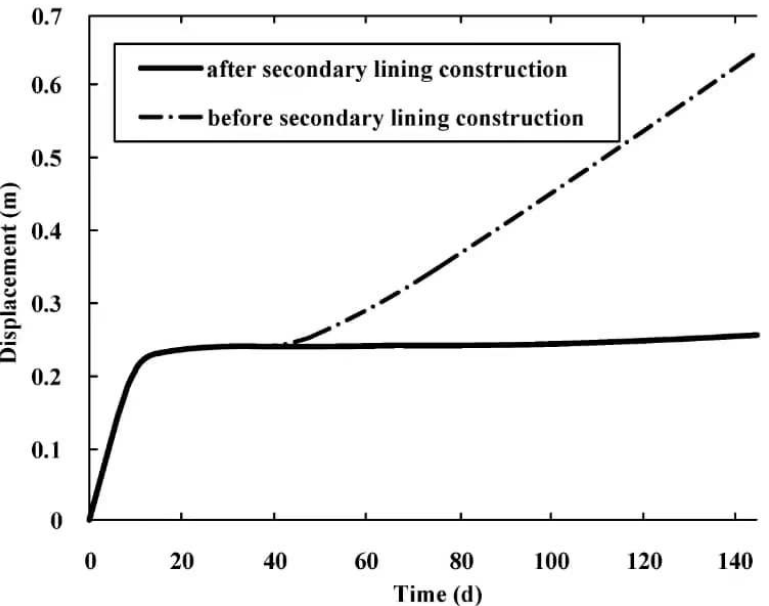
Figure 5. Influence of the installation time of the secondary lining in maintaining surrounding rocks at their steady creep state for a tunnel built in soft rocks. “d” refers to days (reprinted from Huang et al. [129], Copyright©2022, with permission from the publisher, License ID 1238703-1).